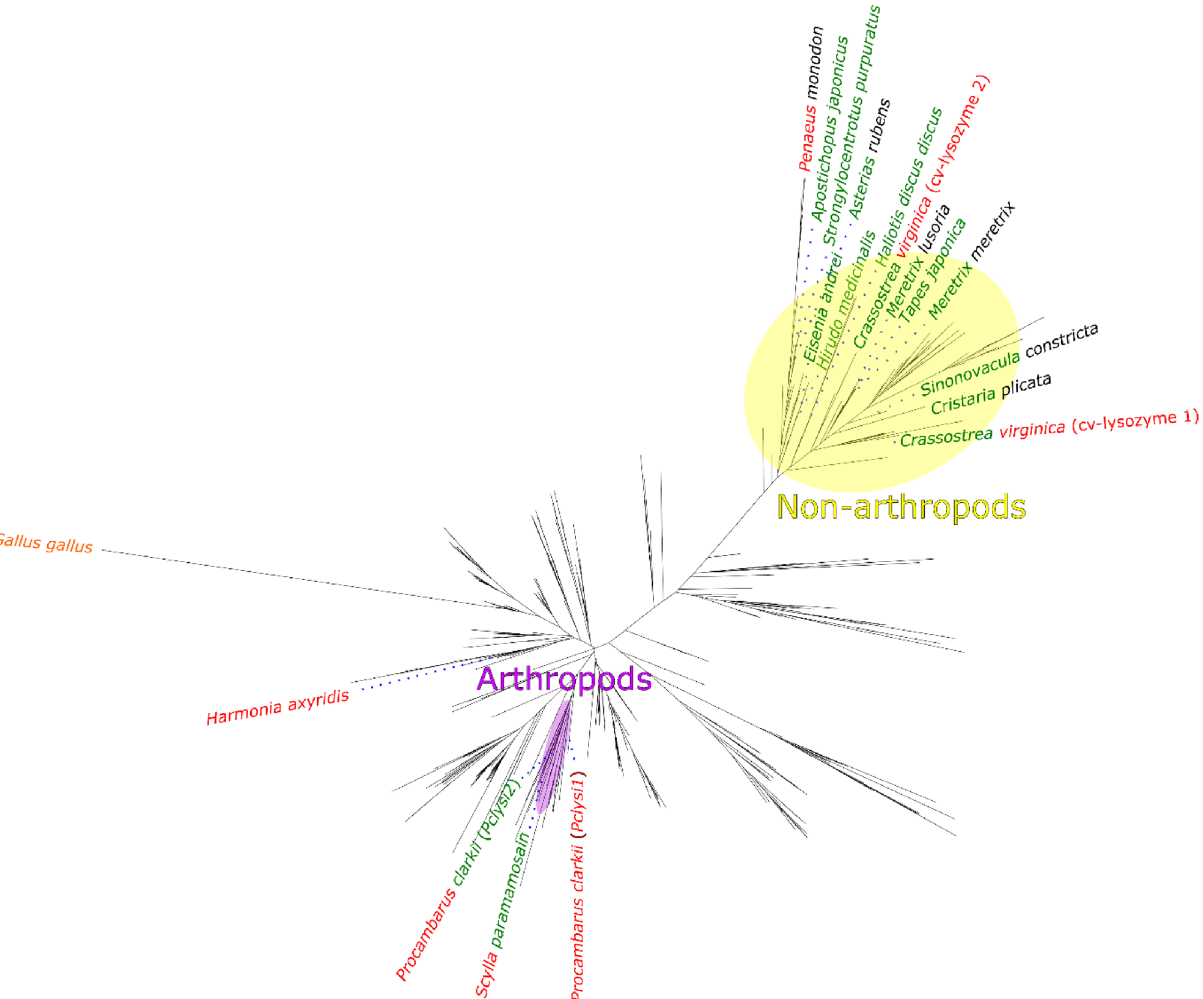
Figure 1. Phylogenetic analysis of Pfam “destabilase” protein family, annotated with information about muramidase and isopeptidase activities and source organisms. An outgroup protein (c-type lysozyme from hen egg Gallus gallus , colored with orange ) is added as a distant relative of i-type lysozymes, indicating the root of the phylogenetic tree. A color of the first half of the organism taxonomy name corresponds to the muramidase activity and the second half—to the isopeptidase activity. Green and red colors mean presence and absence of the corresponded activity respectively, black means no information about the corresponding activity. Violet shows arthropods branch of the tree, yellow—the non-arthropods